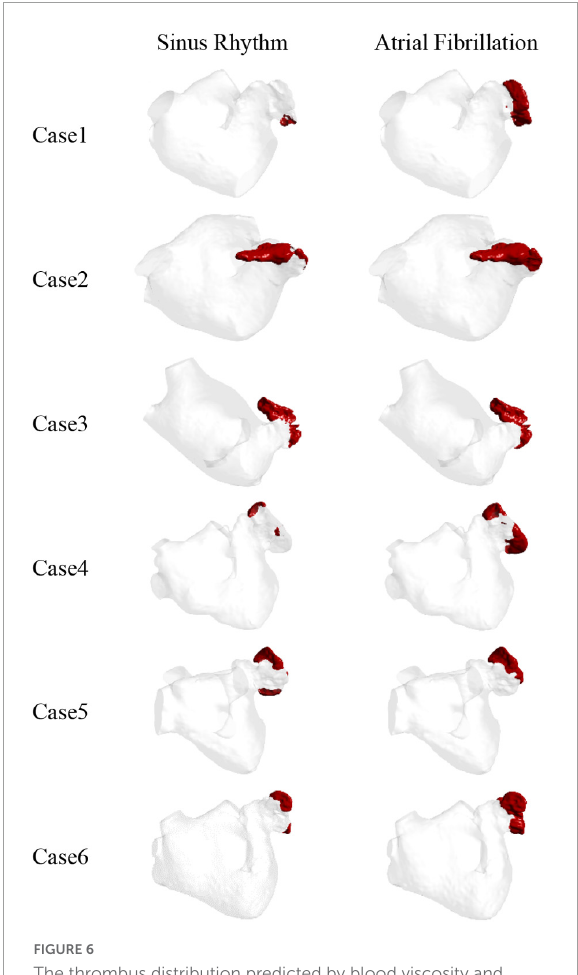
FIGURE6 The thrombus distribution predicted by blood viscosity and shear